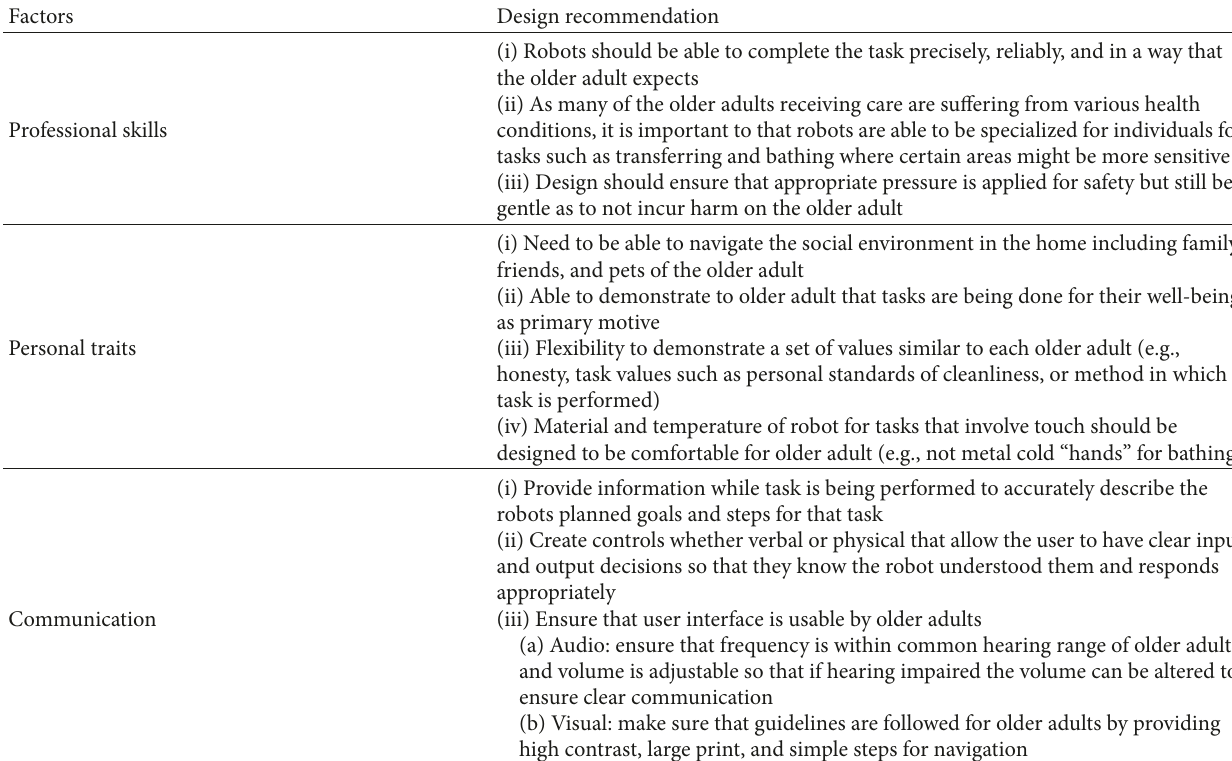
Table 8: Design recommendations for robot care